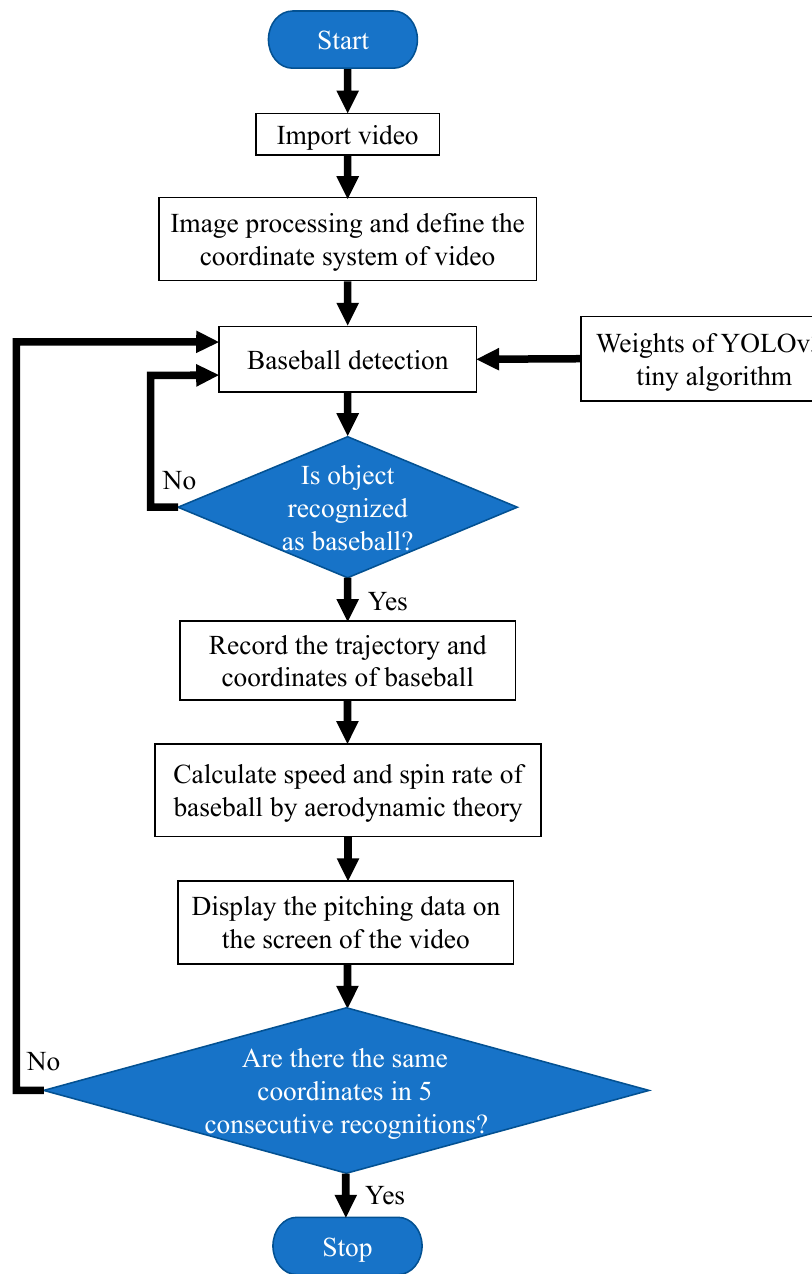
Figure 7. Flowchart of pitched-baseball analysis by YOLOv3-tiny algorithm. Table 1. Results of the network test comparison.